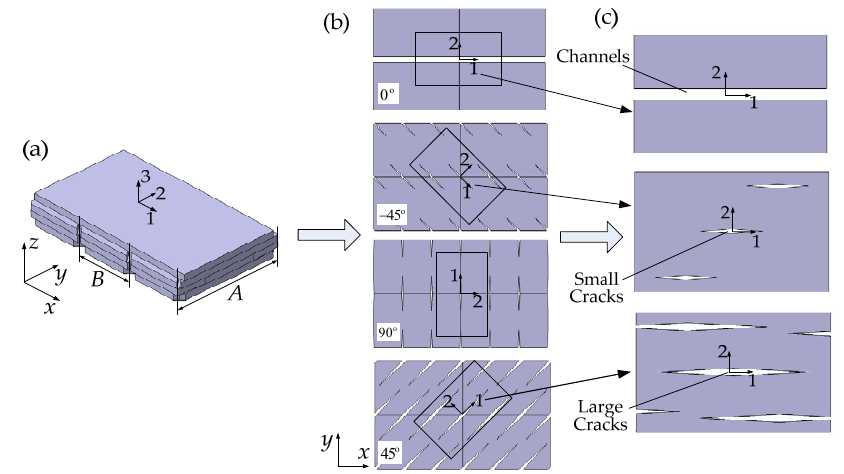
Figure 1. The geometrical model of mesomechanical unit cell development for single quadriaxial non ‐ crimp fabric (QNCF) lamina: ( a ) unit cells of a QNCF layer; ( b ) individual fibrous plies in the QNCF layer; and ( c ) geometrical model of unit cells of individual QNCF lamina.